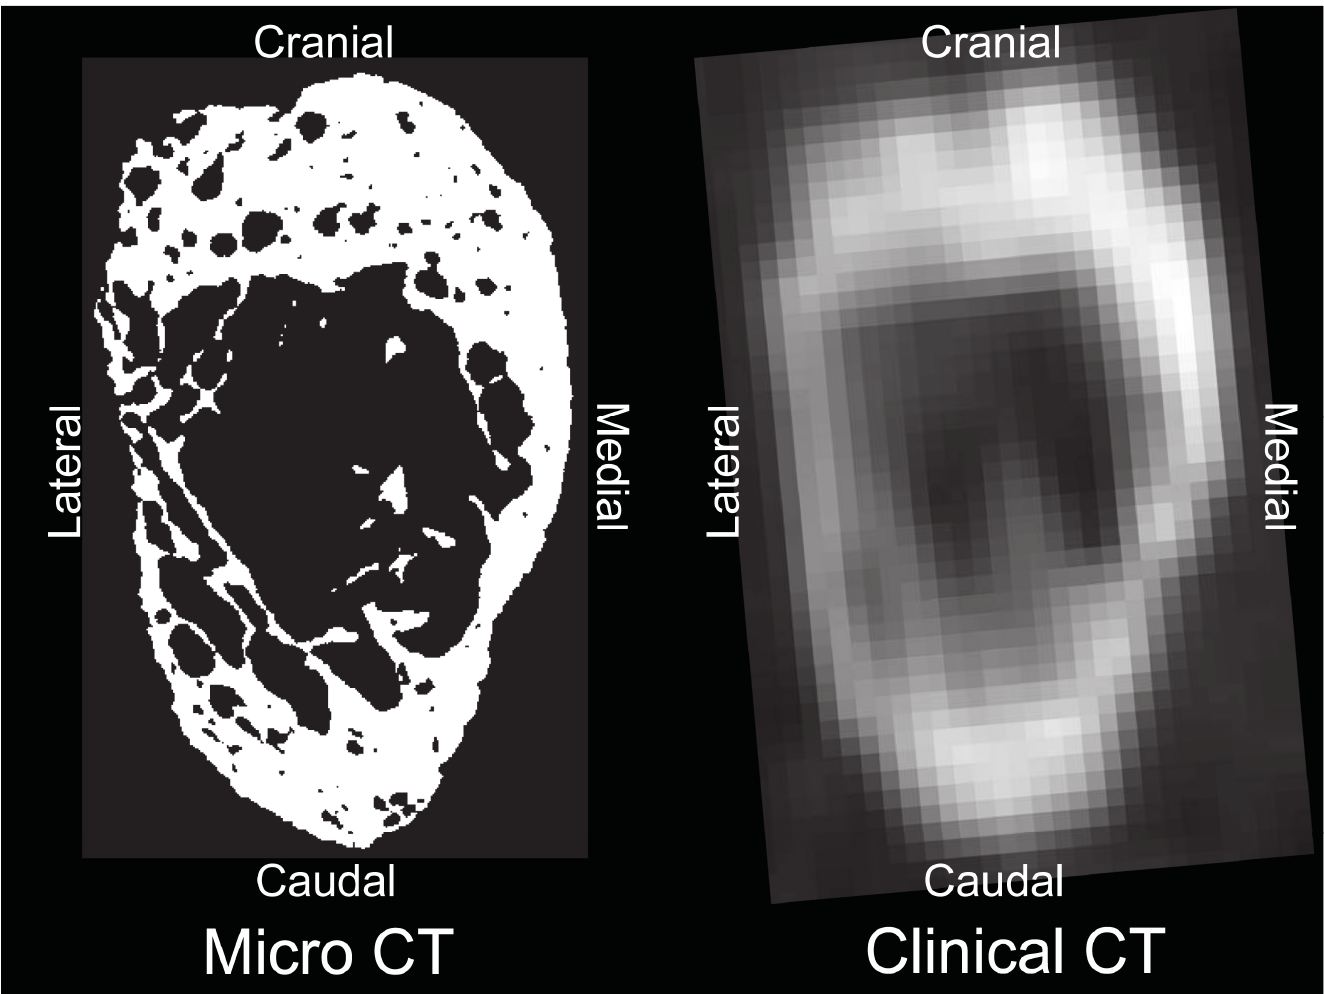
Fig 4. Representative comparison between this study’s μ CT scan and clinical CT scan at the pedicular isthmus for the same specimen. scanned Clinical CT image acquisition parameters: Volume Zoom scanner (Siemens, Malvern, PA), tube voltage: 120 kV, tube current: 100 mA, field of view: 272 mm, image matrix: 512 × 512, slice increment: 1.0 mm, slice thickness: 0.625 mm, no spacing. The difference in resolution is self-evident, leading to less accurate pedicle wall characterization with clinical